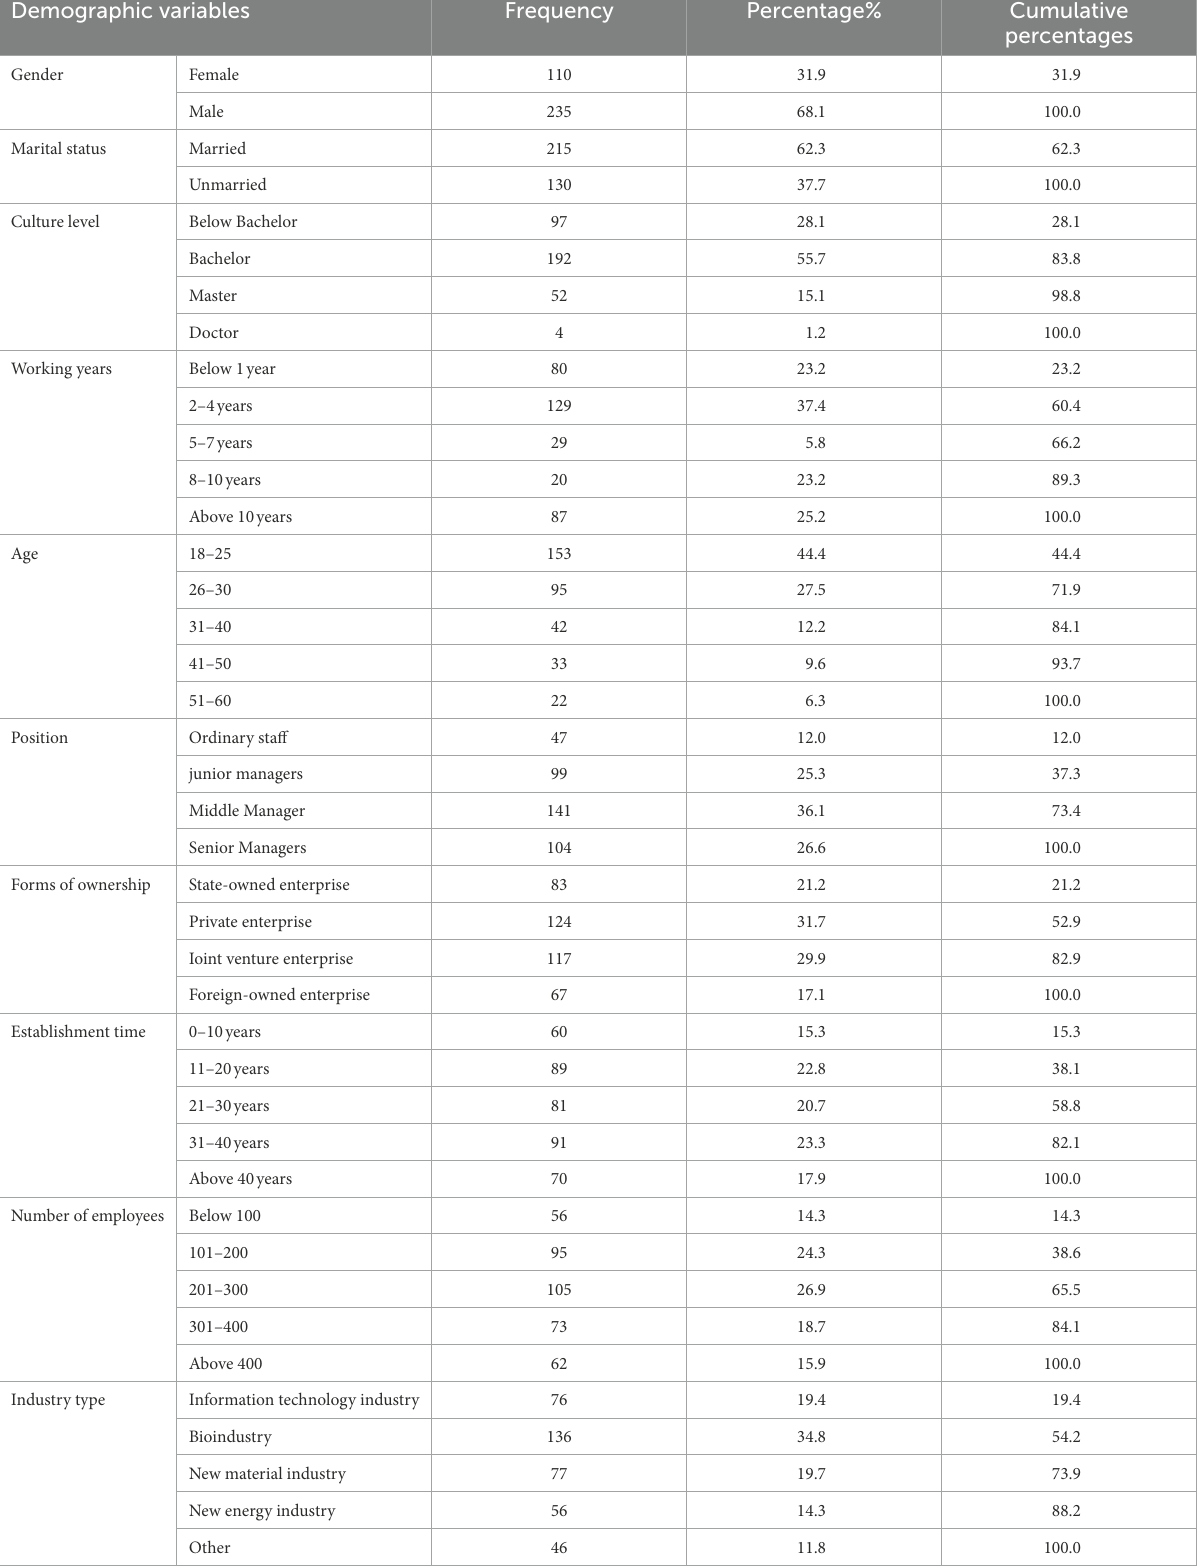
TABLE 1 Descriptive statistical analysis of basic characteristics of